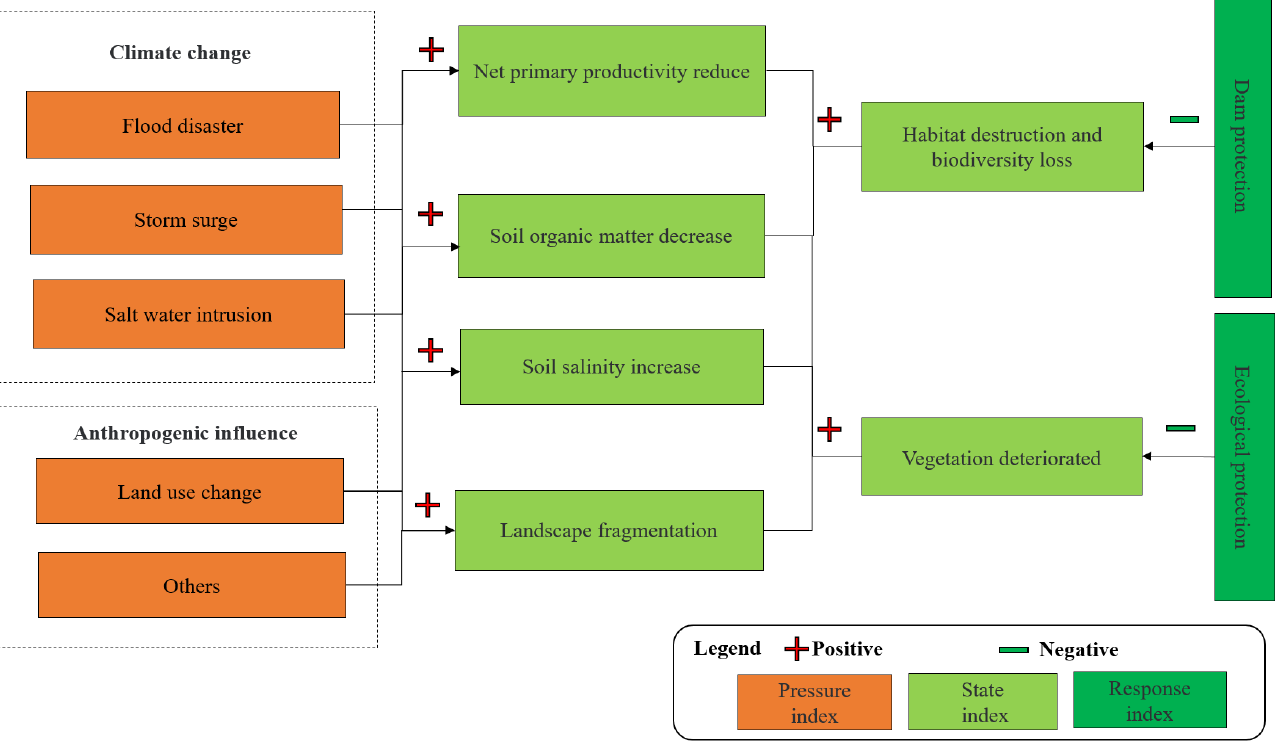
Figure 2. The framework to illustrate the influence factors of ecological vulnerability for estuarine islands. Table 1. The selected indicators of the estuarine islands’ ecological vulnerability assessment index system [57–60]. Criterion